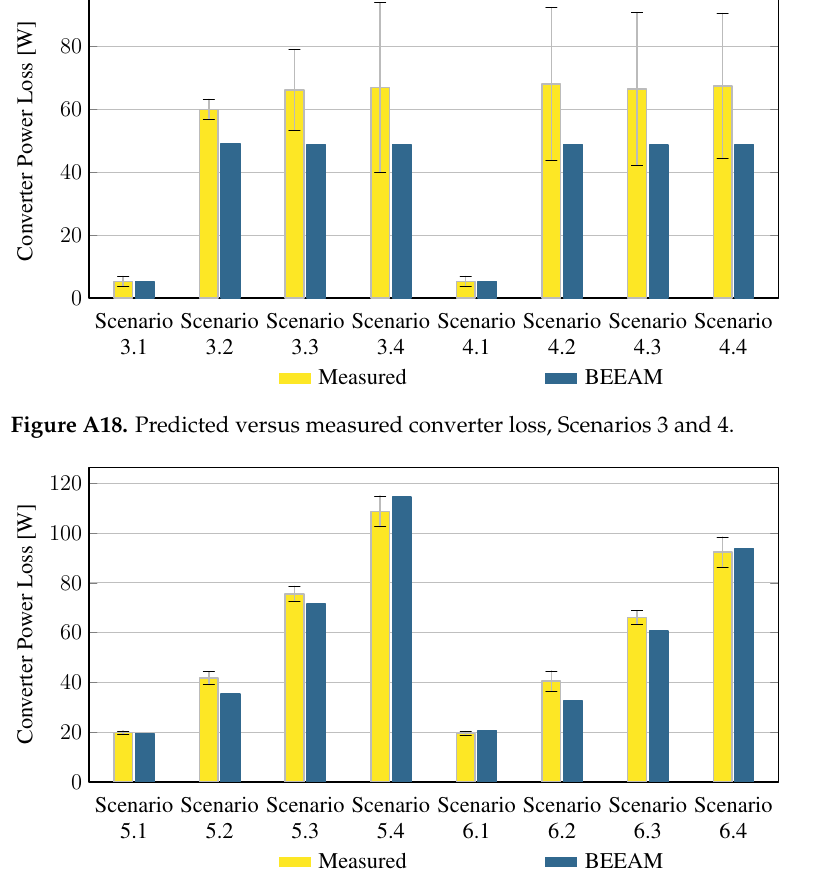
Figure A19. Predicted versus measured converter loss, Scenarios 5 and